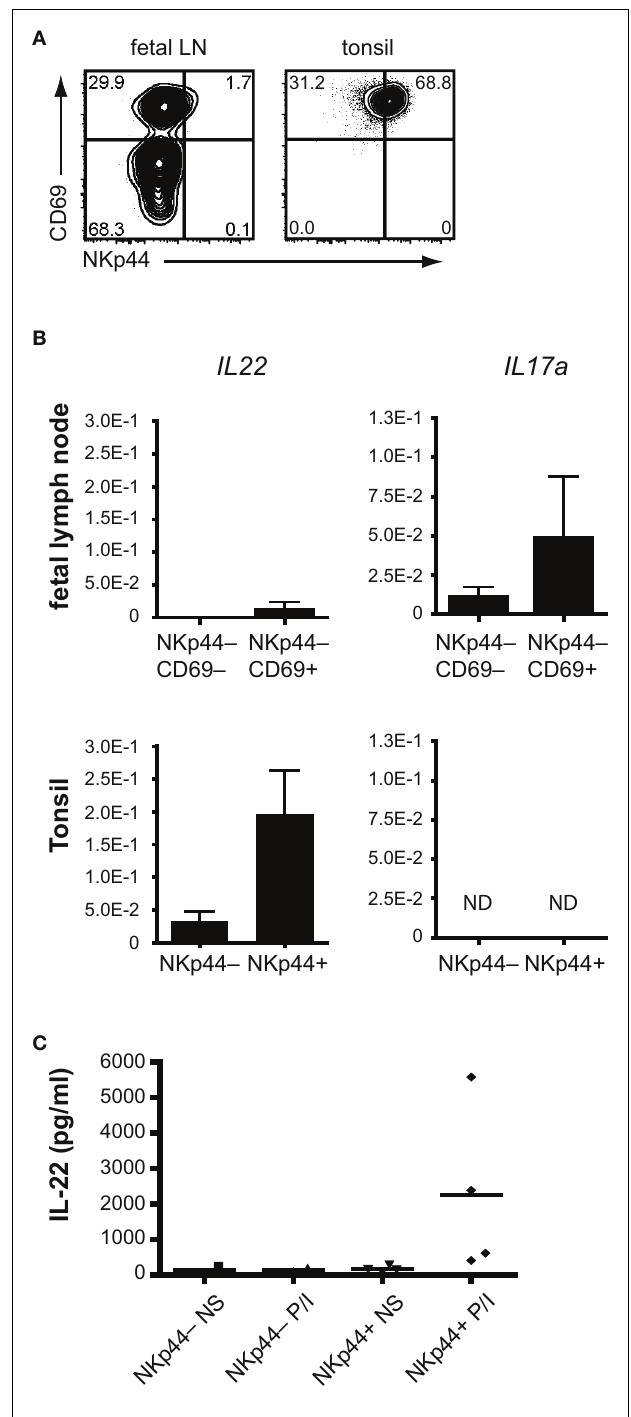
FIGURE 3 | Differential cytokine production by NKp44 + and NKp44 − ILC. (A) Flow cytometric analysis of CD69 and NKp44 expression on RORC + ILC from fetal LN and tonsil (representative example of three independent experiments). (B) Expression of IL22 and IL17A mRNA in sorted ILC populations from tonsils and fetal LN (representative of two individual experiments with three to five donors per experiment). (C) IL-22 protein production by NKp44 − and NKp44 + ILC from tonsils stimulated overnight with PMA + ionomycin ( n =